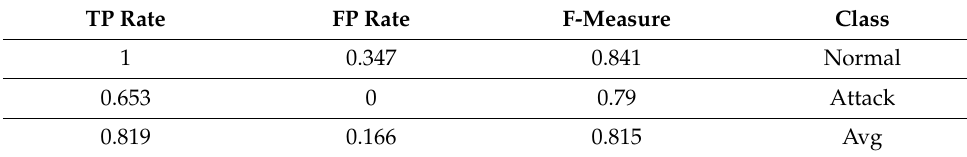
Table 10. Detailed accuracy of SVM.